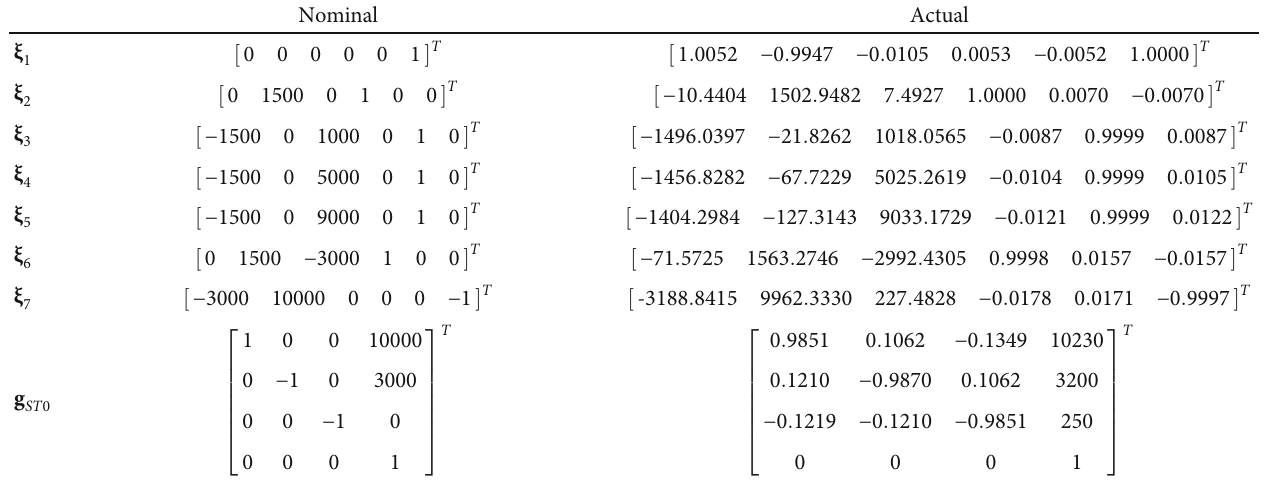
Table 4: Kinematics parameters of the